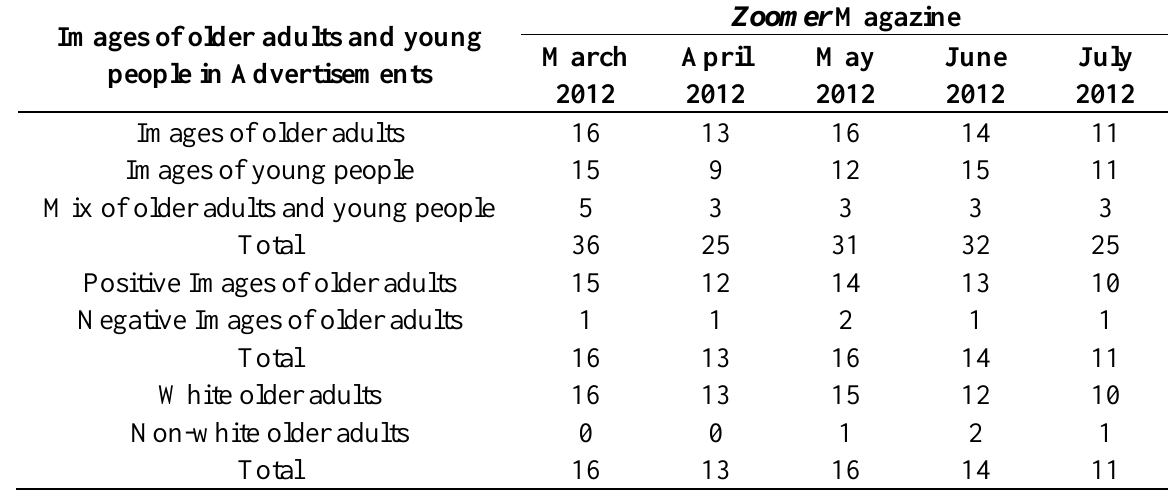
Table 3. Older Adults and Younger people in Zoomer Magazine Advertisements March–July 2012. Images of older adults and young